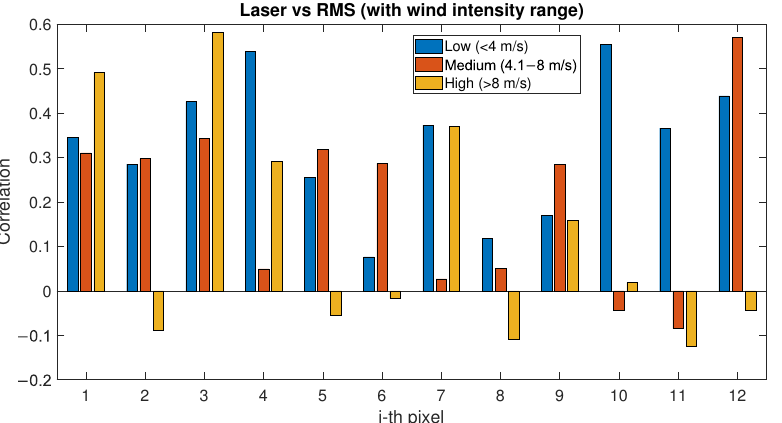
Figure 15. Correlation factor between PLS intensity and RMSH evaluated for low-, medium- and high-wind-speed conditions.